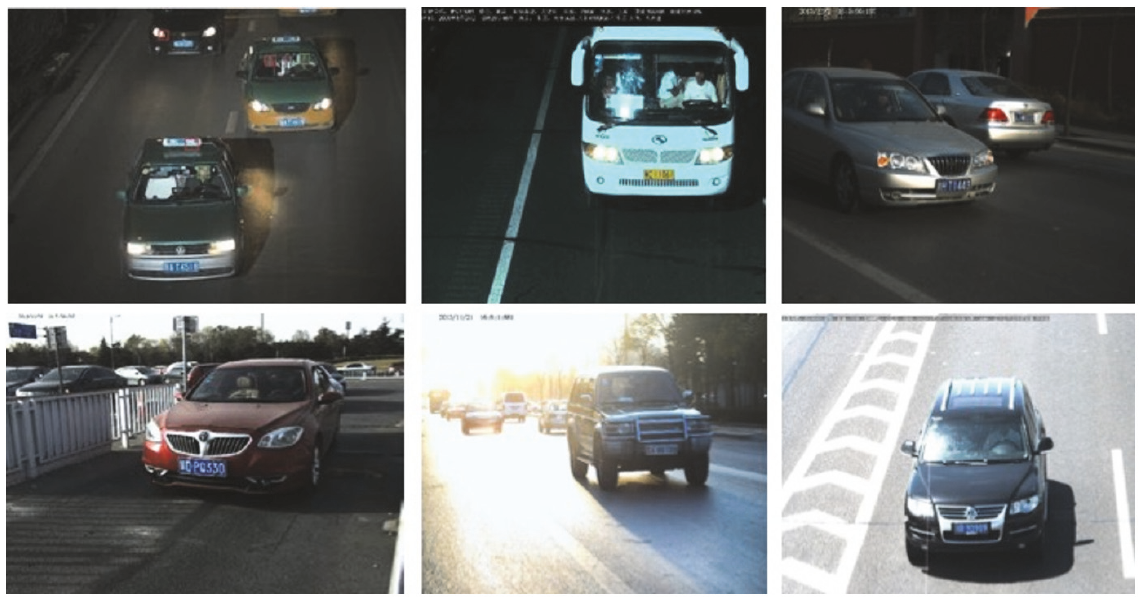
Figure 3: Some sample images of BIT-Vehicle Dataset. Table 1: Comparison